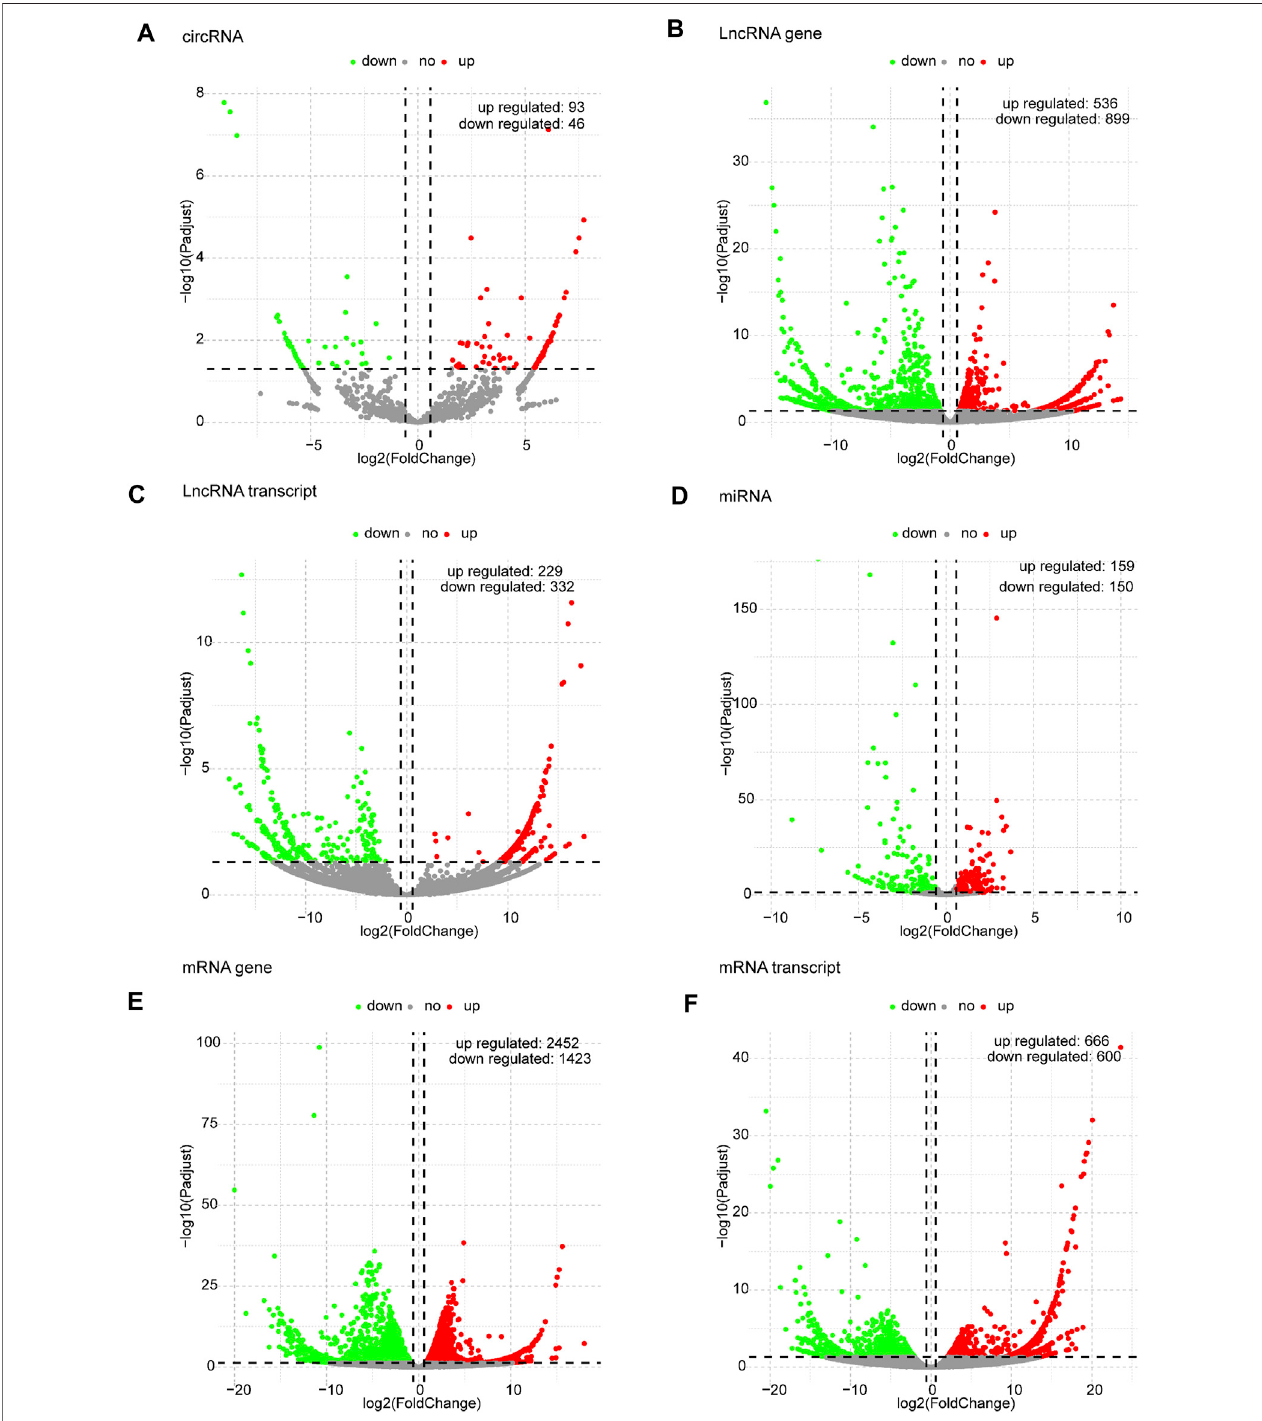
FIGURE 3 | Volcano plots of differentially expressed RNAs in x12A astrocytes. (A) circRNA, (B) lncRNA gene level, (C) lncRNA transcript level, (D) miRNA, (E) mRNA gene level, and (F) mRNA transcript level in astrocytes treated with A β . Red and green indicate up and downregulation, respectively.